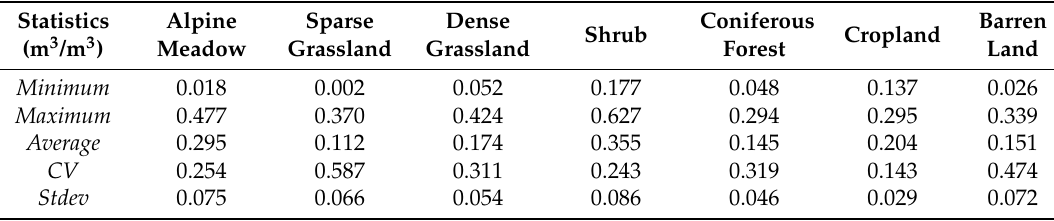
Table 8. Statistics of in-situ observation under different vegetation